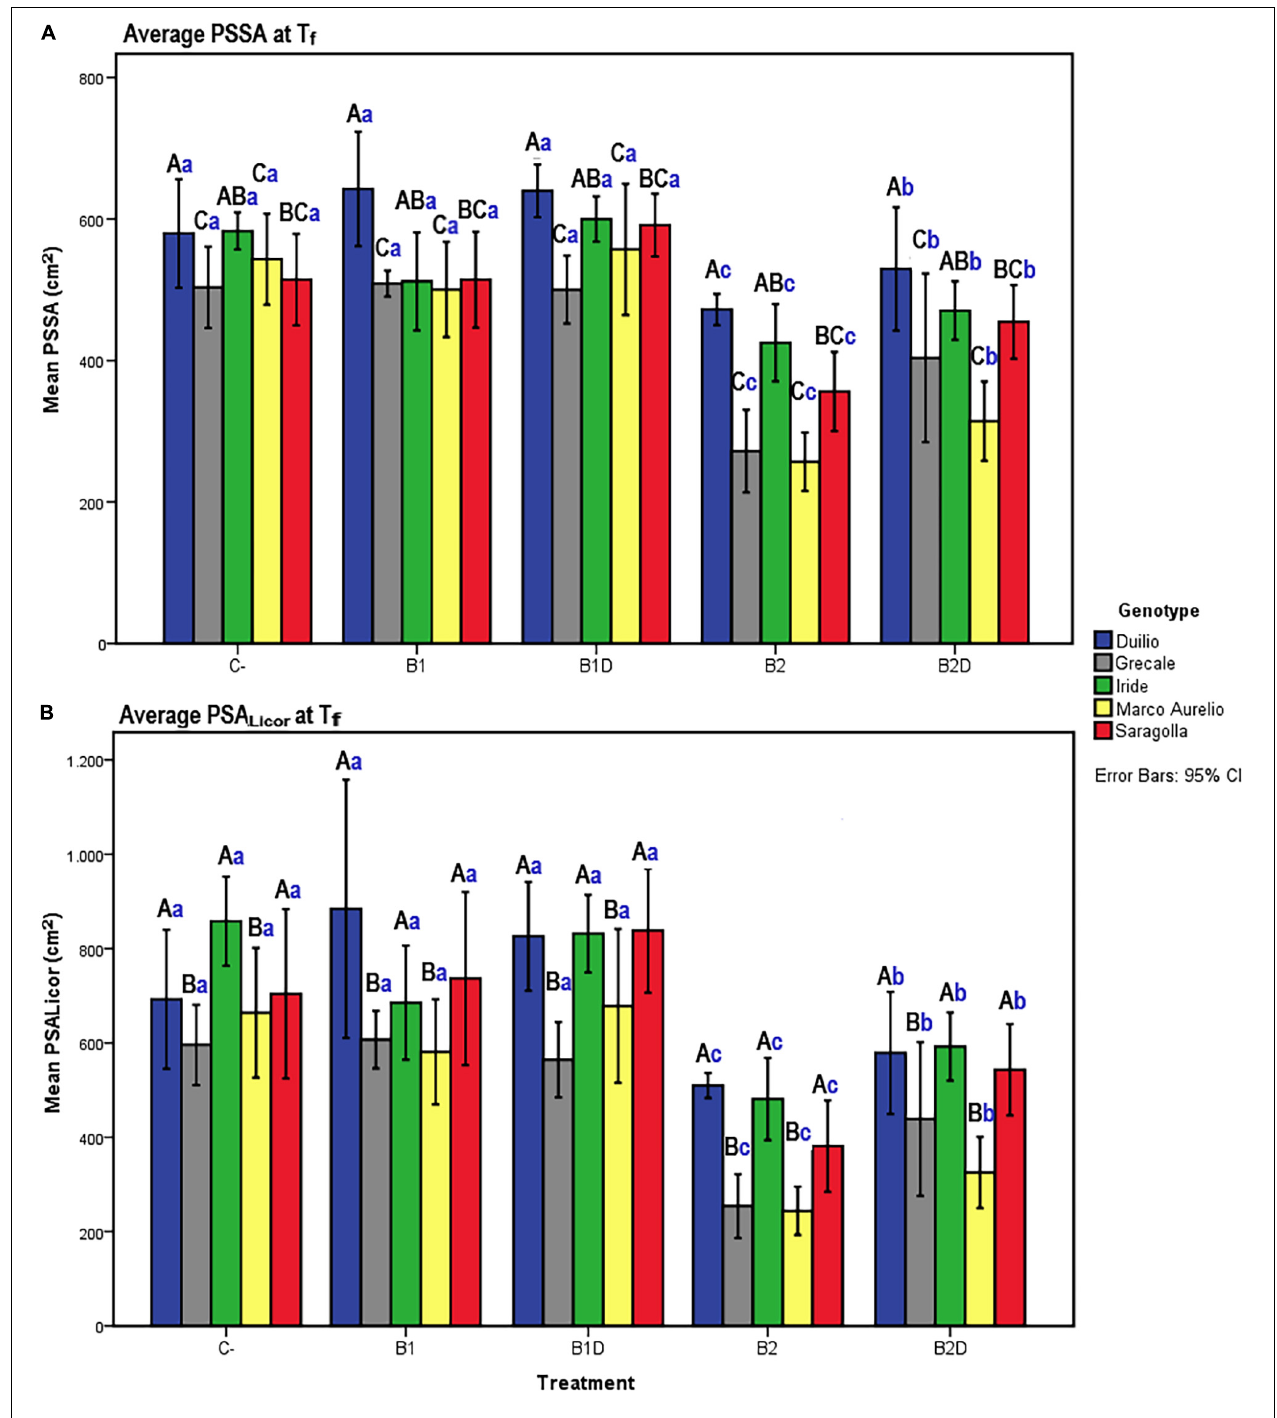
FIGURE 3 | (A) PSSA and (B) plant shoot area measured with Licor area meter (PSA Licor ) at T f as a function of the genotype and treatment. Bars represent mean values, with error bars denoting 95% confidence interval (CI). Different bold letters indicate significant difference according to the R-E-G-W-Q test at the p < 0.001 level, with the black uppercase letters referring to the “genotype” subset and the blue lowercase ones to the “treatment” subset ( Supplementary Material 2 ).